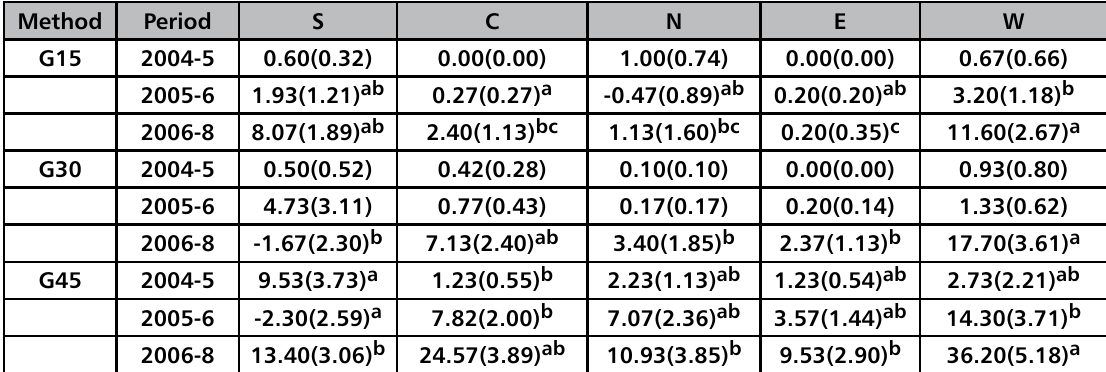
Spread of blackberry in different locations of gaps of various sizes (spatial analyses). The cells contain average values (in %) of change in cover during a given period. Standard errors are shown in brackets. The significantly different values (p ≤ 0.05) are marked with different letters in the upper indices.